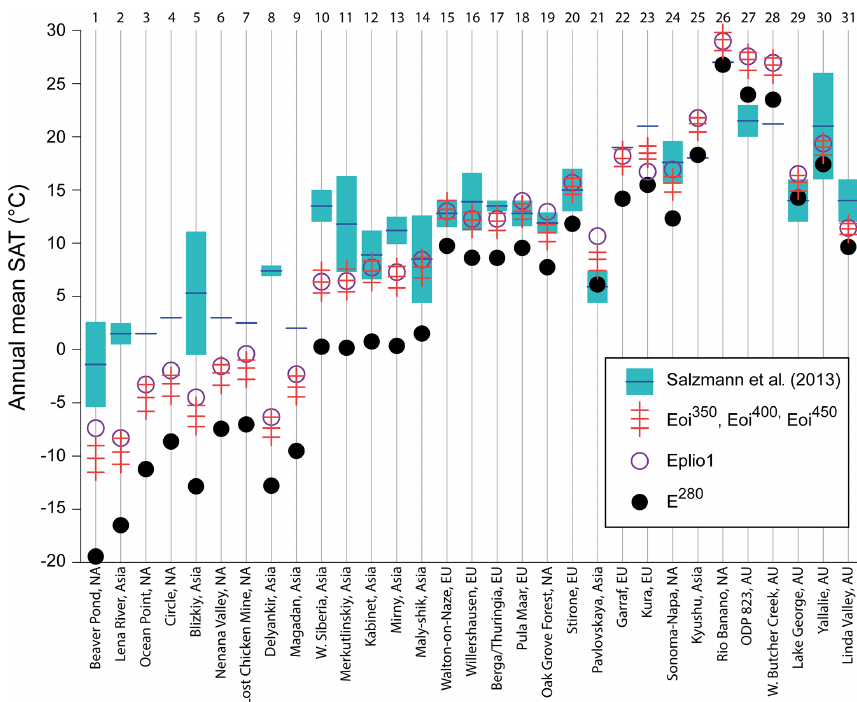
Figure 15. Comparison of annual mean surface air temperatures derived from terrestrial proxy data (Table S3a of Salzmann et al., 2013) and those from model experiments. Proxy data are indicated by the dark blue line and the uncertainty range by light blue. The three red marks represent, from top to bottom, E 450 , E 400 and E 350 . Abbreviations used at the bottom of the figure: NA: North America; EU: Europe; AU: